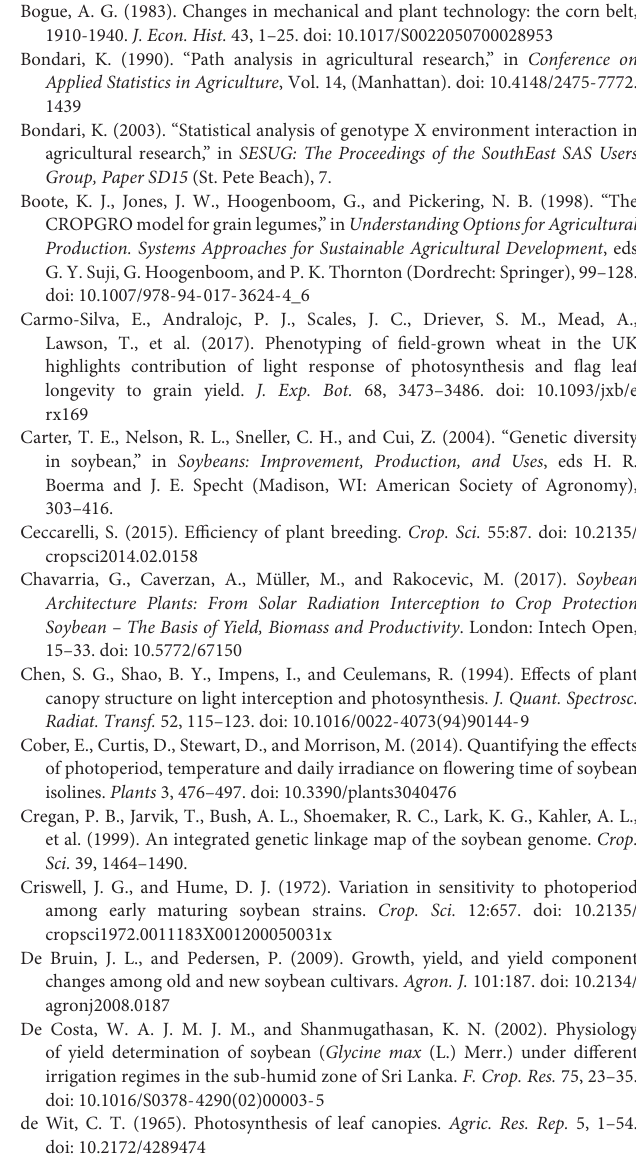
Supplementary Table 5 | Water balance for the location ACRE_2018. Supplementary Table 6 | Water balance for the location